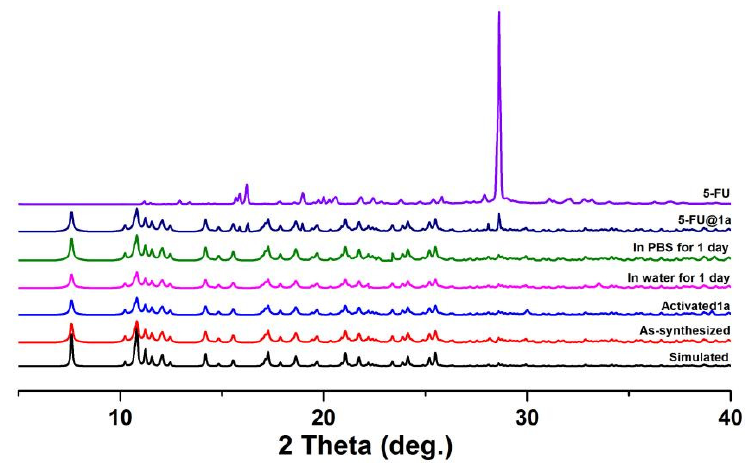
Figure 4. TGA curves of complex 1 , complex 1a , 5-FU, and 5-FU@ 1a .